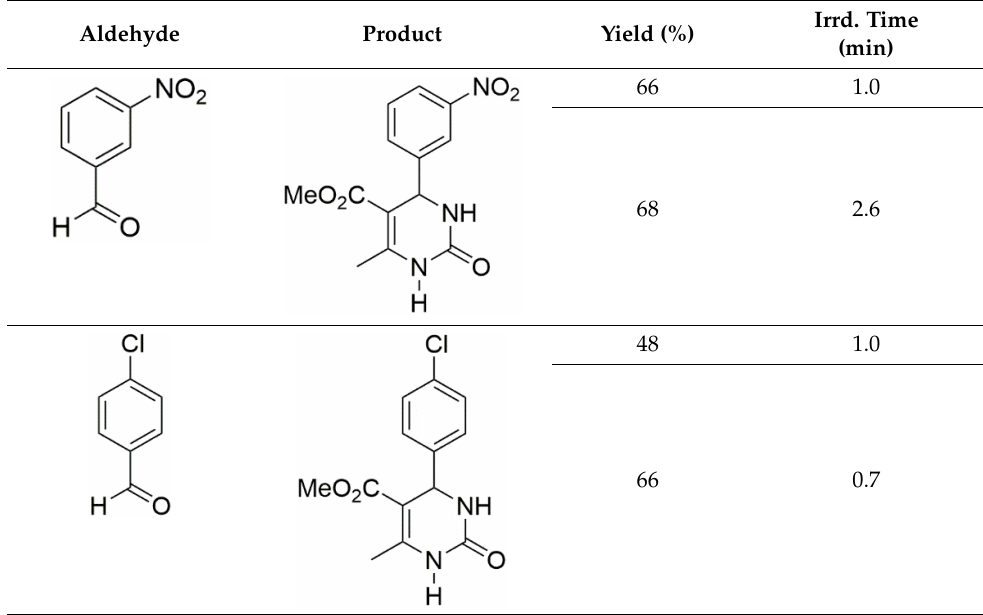
Table 5. DHPMs synthesized using different aldehydes without any solvents and